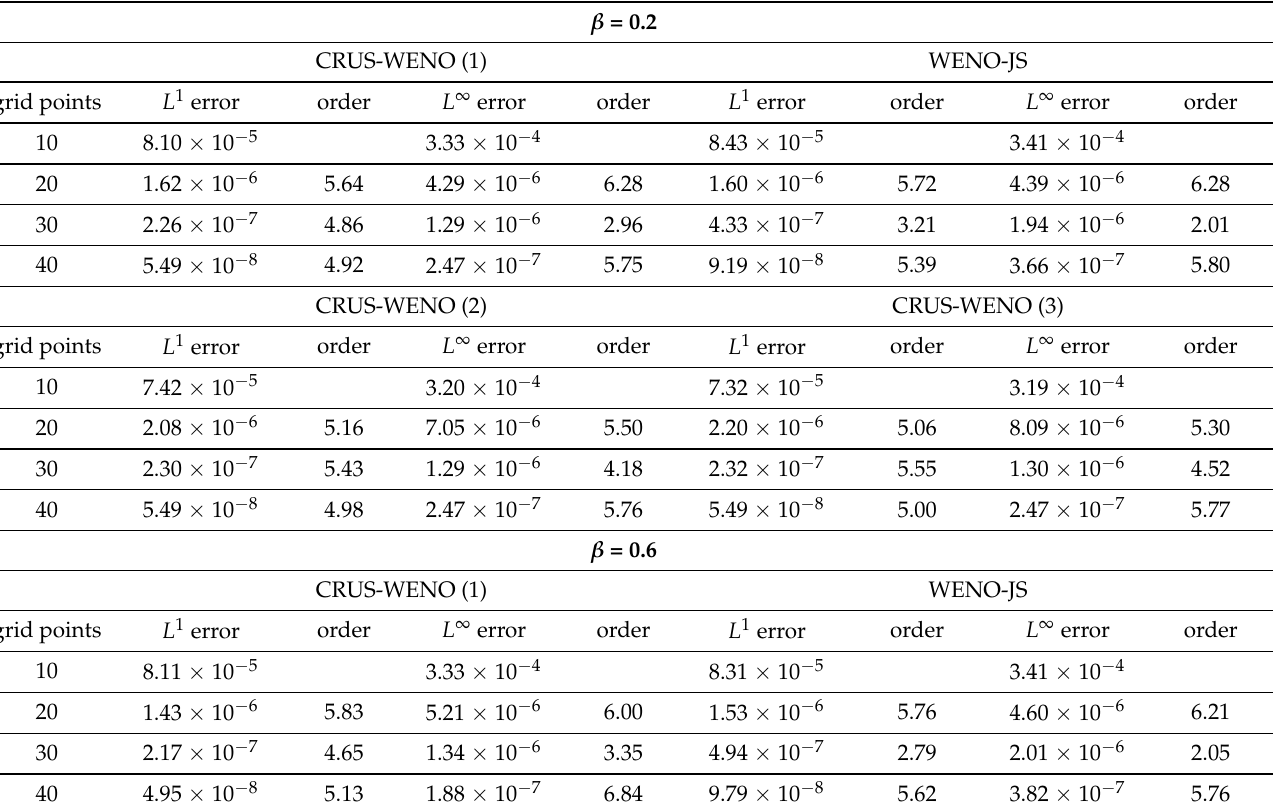
Table 2. The errors and orders of the accuracy of Example 2 at t = 0.1. β =